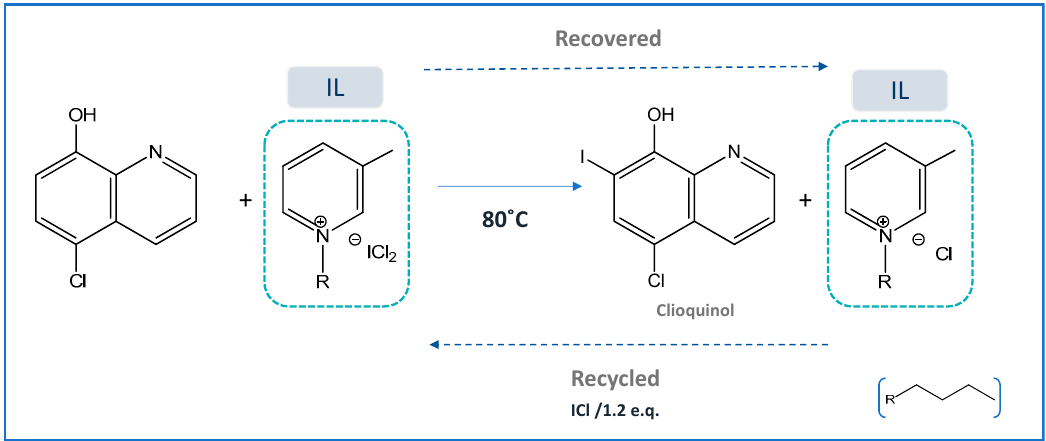
Figure 6. IL application as solvent and iodinating agent in the synthesis of clioquinol proposed in [57].